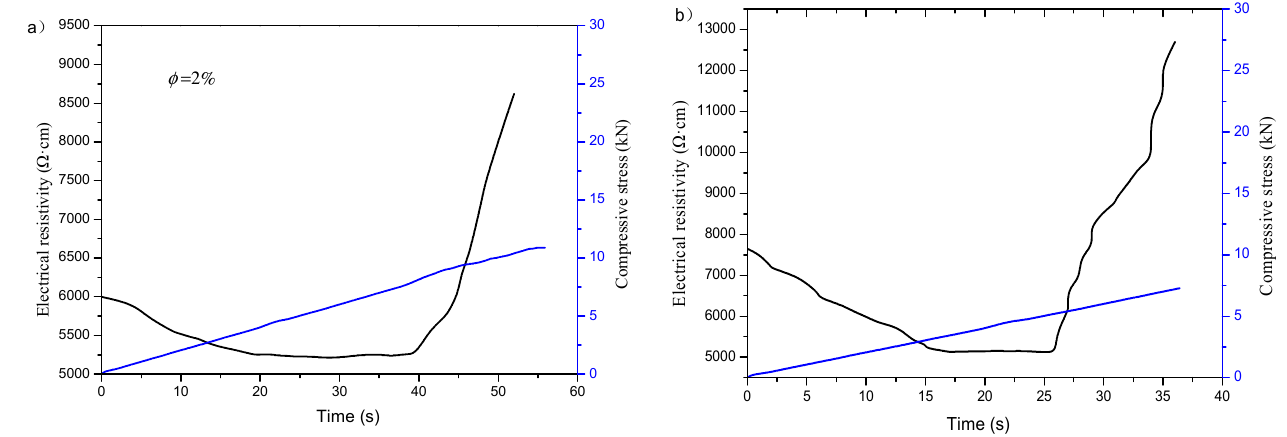
Figure 17. Relationship of electrical resistivity and compressive stress of specimens incorporating 2% content of graphene under monotonic loading: ( a ) before freeze–thaw; ( b ) after freeze–thaw. Here, the pressure sensitivity of graphene-based cement composites is defined as